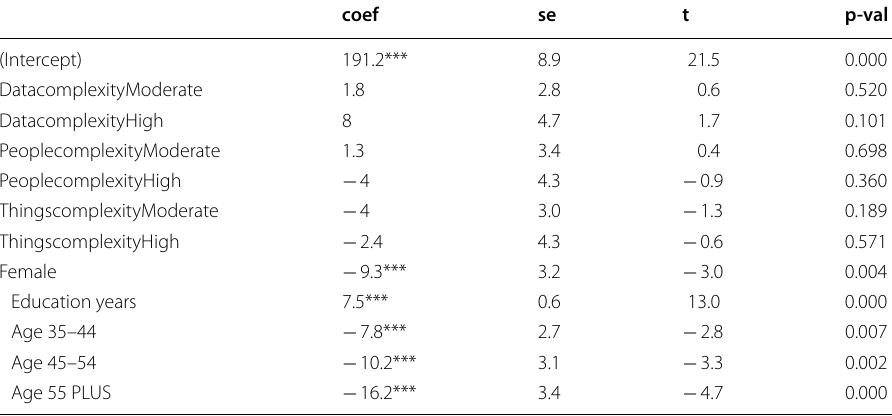
Table 12 Regression results for Czech Republic. Source: PIAAC 2012, DOT index, ISCO-08 codes